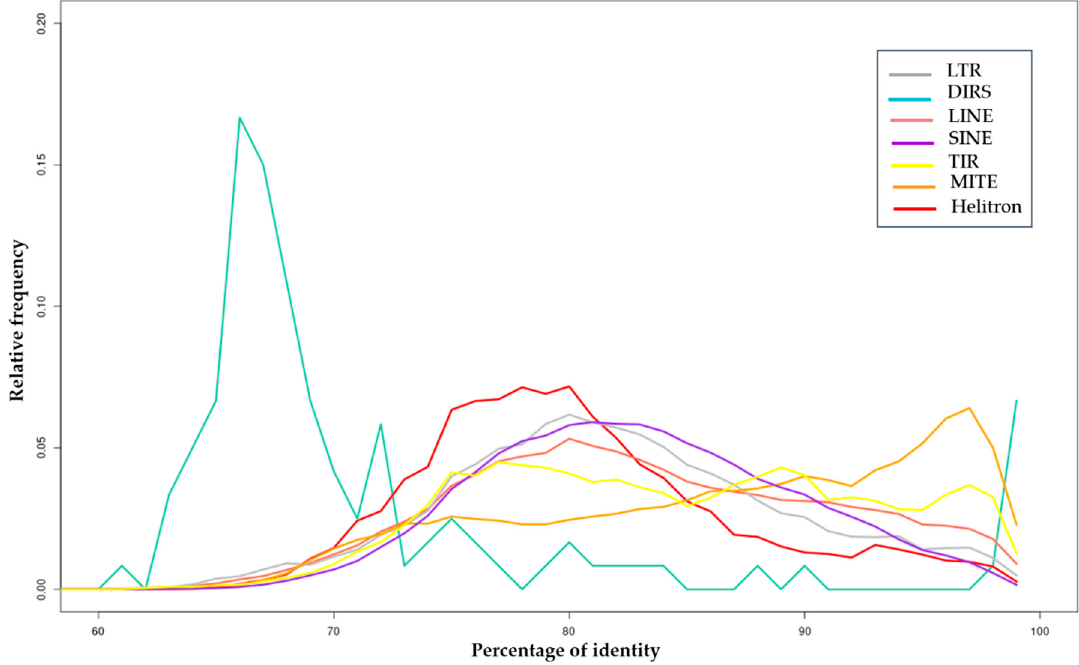
Figure 3. Distribution of sequence identity values between TE copies and TE sequences with at least one FLC. The relative frequencies per percentage of identity of Dictyostelium transposable element (DIRS), Helitron, Long and Short Interspersed Nuclear Elements (LINE and SINE), Long Terminal Repeat (LTR), Miniature Inverted Transposable Element (MITE) and Terminal Inverted Repeat (TIR) orders are represented in di ff erent colors. Only the main orders (in terms of copy number) are